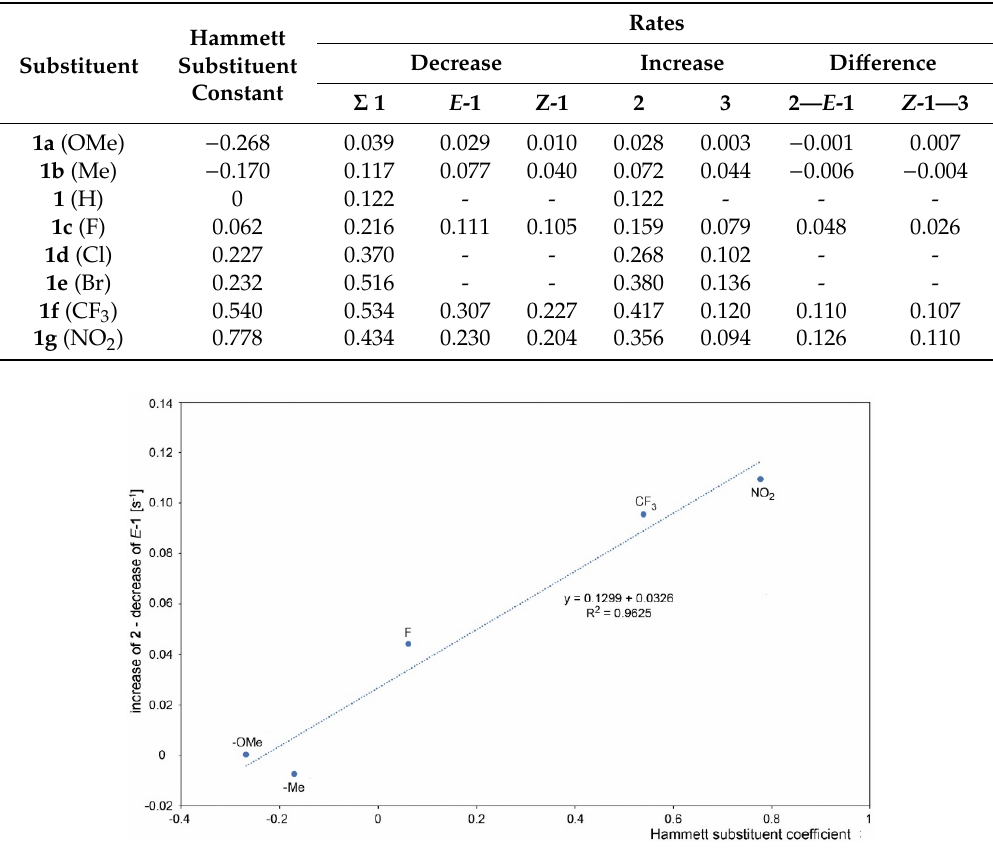
Figure 4. The contribution of Z - 1 to the formation of 2 , calculated as the rate of 2 formation minus a decrease of E - 1 concentration and its correlation to the Hammett para-substituent coefficient.